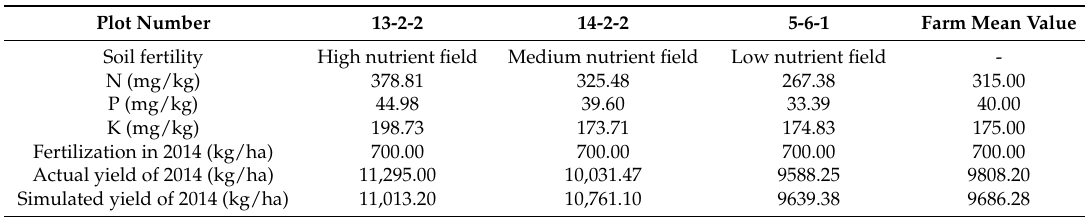
Table 7. Field details for the selected